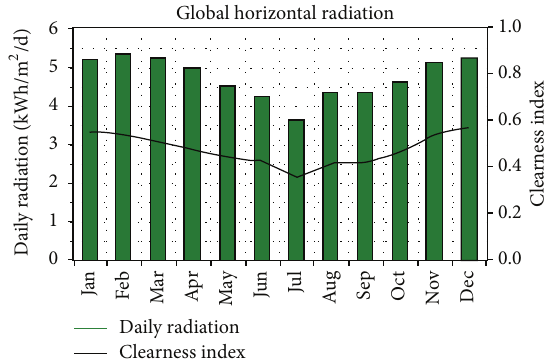
Figure2:SolardailyradiationprofileforNdiagu-AkpugoinNkanu- West (Enugu State)